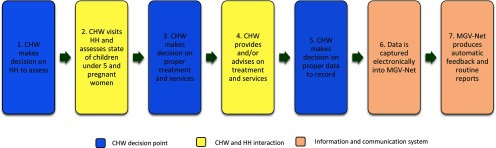
MVG-Net System Framework: Data-Driven Feedback in Real Time to CHWs for Improved Decision MakingAbbreviations: CHW, community health worker; HH, households; MVG-Net, Millennium Villages Global Network.